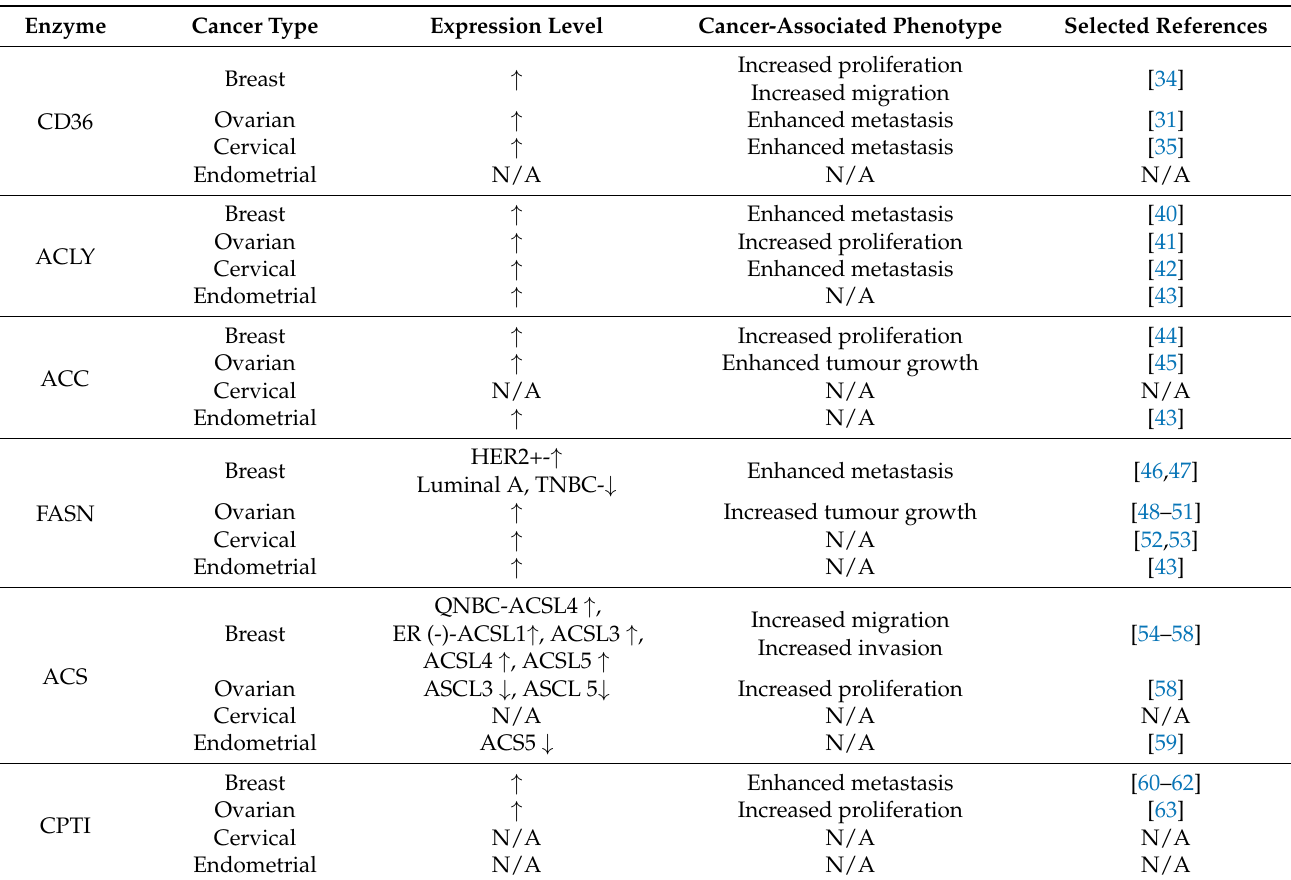
Table 1. Summary of the various fatty acid metabolism enzymes and their effects on the phenotypes of gynaecological